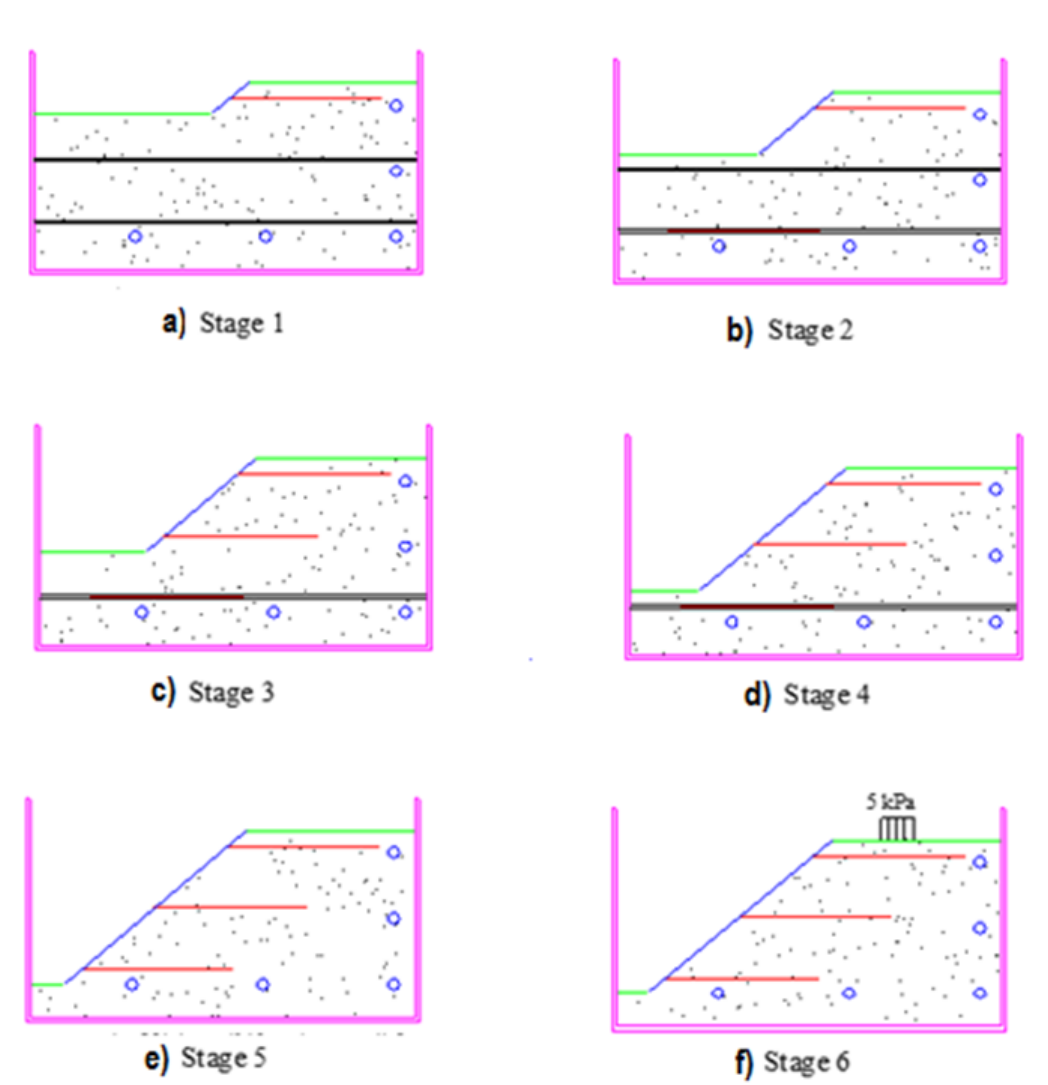
Figure 2. Slope-nailed system construction stages [21].